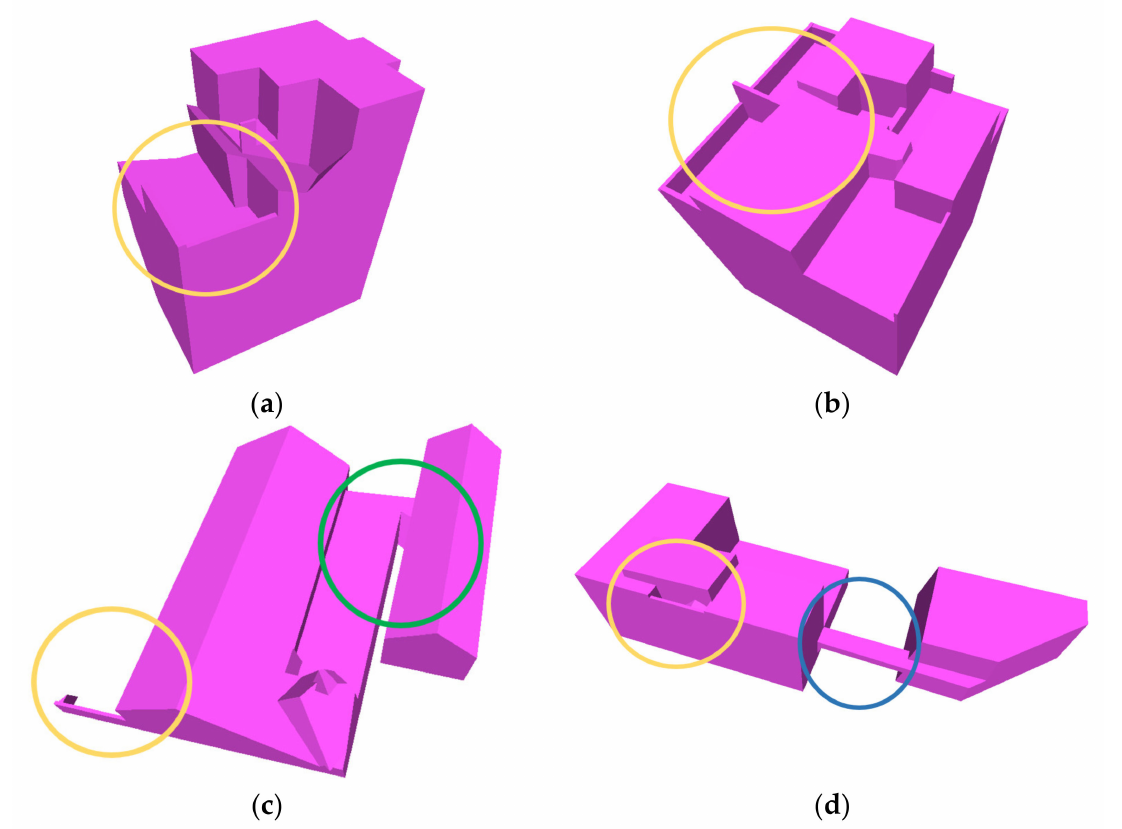
Figure 11. Example of structure-preserving capabilities. ( a ) Several parapets (gold circle) are successfully restored; ( b ) as a result of the restoration of the parapet, the adjacent structure is correctly reconstructed; ( c ) as a result of the topological modification of the slit region (green circle), the building structure on the left is also correctly restored; ( d ) connecting corridor (blue circle) is properly rebuilt.